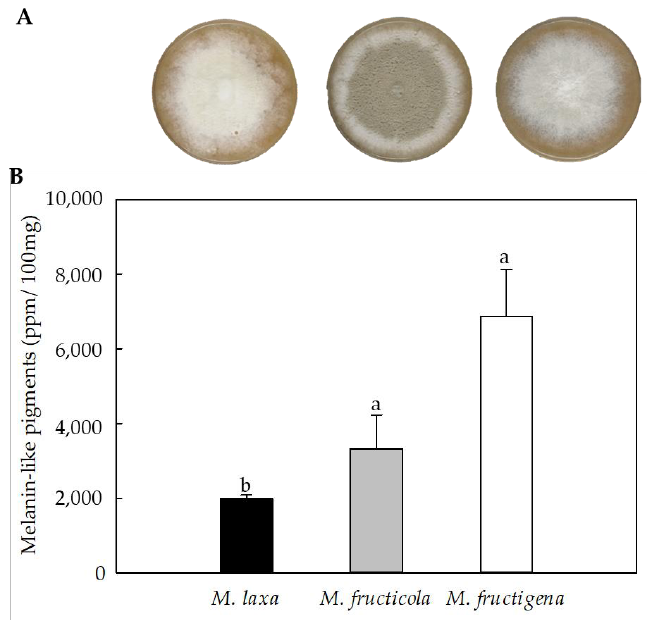
Figure 2. ( A ) In vitro phenotype of M. laxa , M. fructicola , and M. fructigena grown on PDA-T medium and incubated for seven days under darkness. ( B ) Spectrophotometric quantitation (OD 414 ) of melanin-like pigments expressed as parts per million (ppm) in M. laxa , M. fructicola, and M. fructigena grown on PDA-T medium and incubated for seben days under darkness. Letters indicate significant differences ( p ≤ 0.05) between species. The error bars represent the standard deviation of the means (n = 3).